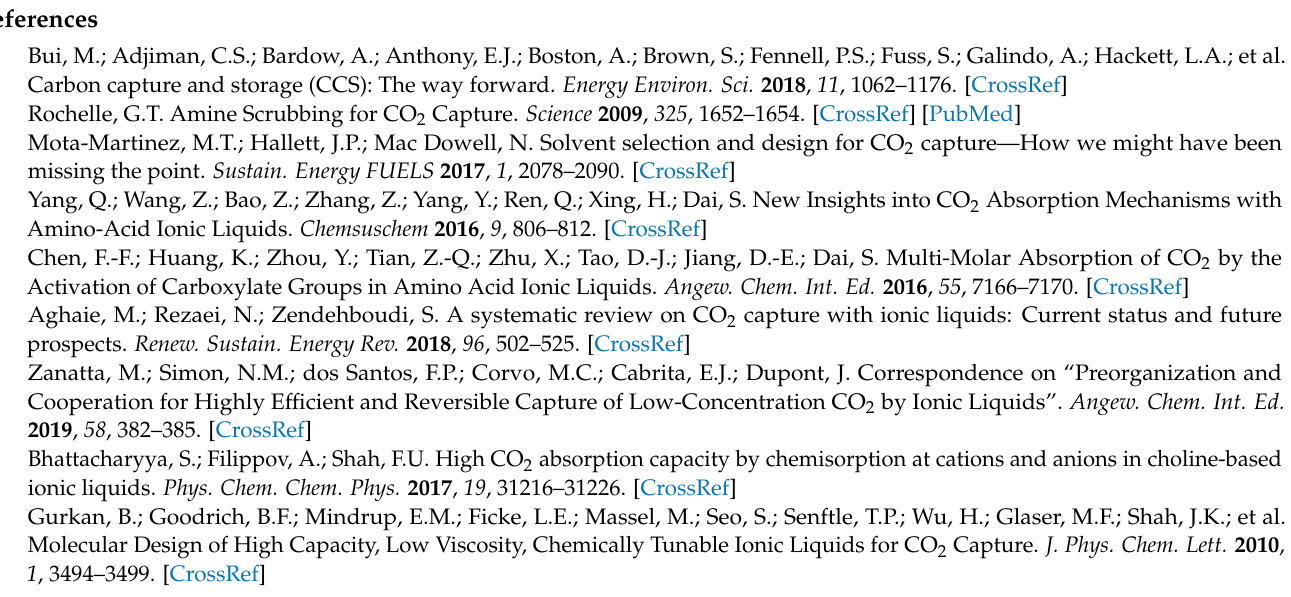
DMSO- d 6 , Figure S2: 1 H (A) and 13 C (B) NMR spectra of [DMEDAH] [Im] after CO 2 absorption; D 2 O was used as the internal solvent to record the spectra, Figure S3: 1 H (A) and 13 C (B) NMR spectra of [DMEDAH] [Py] before and after CO 2 absorption; DMSO-D 6 was used as the external solvent, Figure S4: 1 H (A) and 13 C (B) NMR spectra of [DMEDAH] [Tz] before and after CO 2 absorption; DMSO-D 6 was used as the external solvent, Figure S5: The 1 H- 13 C HMBC spectra of [DMEDAH] [Py] after CO 2 capture; D 2 O was used as the internal solvent to record the spectra, Figure S6: The 1 H- 13 C HMBC spectra of [DMEDAH] [Tz] after CO 2 capture; D 2 O was used as the internal solvent to record the